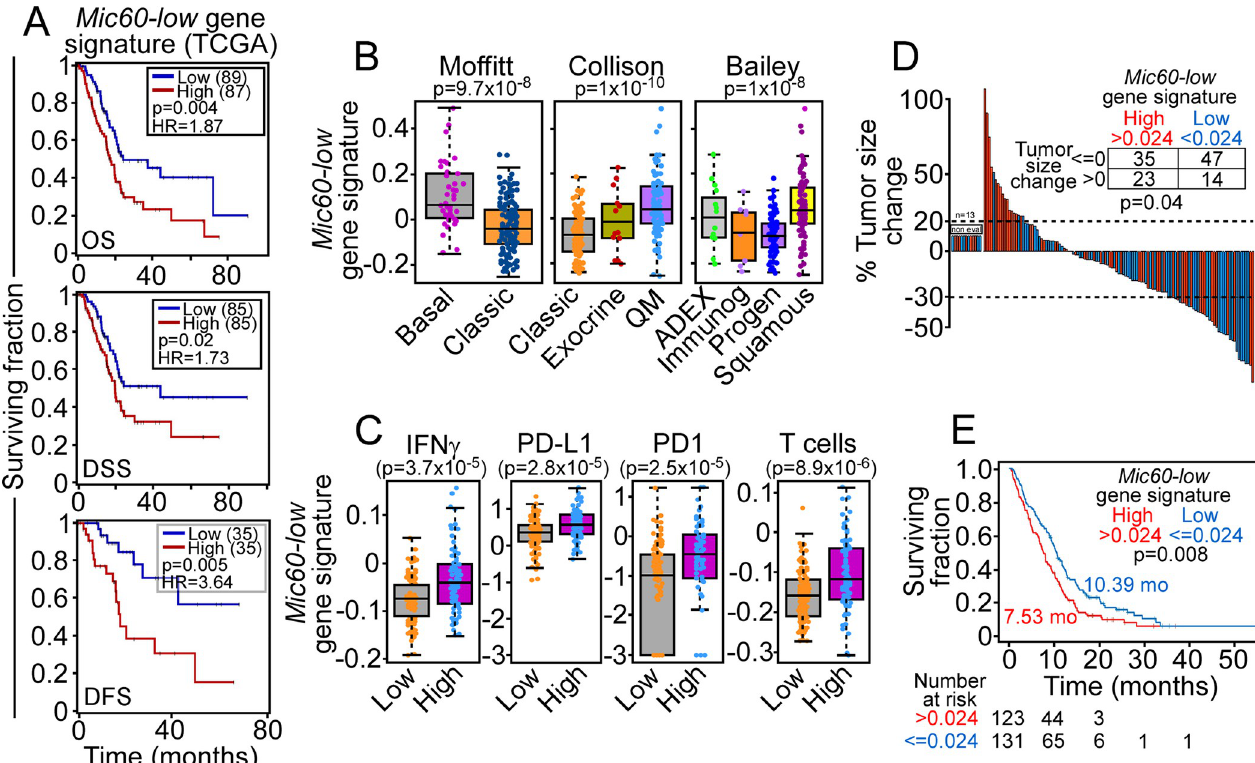
Fig 3. Mic60-low gene signature and PDAC risk. (A) Kaplan-Meier plots of PDAC overall survival (OS), disease-specific survival (DSS) and disease-free status (DFS) determined by univariate Cox regression tests in the TCGA datasets (N = 32). (B) Expression of the 11-gene Mic60-low gene signature in PDAC molecular subtypes by Wilcoxon rank sum test (Moffitt) and Kruskal Wallis test (Collison, Bailey). QM, quasimesenchymal; ADEX, aberrantly differentiated endocrine exocrine; Immunogen, immunogenic; Progen, pancreatic progenitor. (C) Modulation of inflammation-associated markers, IFN γ , PD-L1, PD1 and T cells all by Wilcoxon test. (D) Waterfall plot of tumor size changes in PDAC patients treated with FOLFIRINOX by Wilcoxon test. non-eval, non-evaluable. (E) Kaplan-Meier survival curve of PDAC overall survival (95% CI: 0.533–0.9118). Analyses were carried out by single-sample Gene Set Enrichment Analysis (ssGSEA) with Mic60-low gene signature high ( > 0.024) or low ( < = 0.024) and Wilcoxon test.